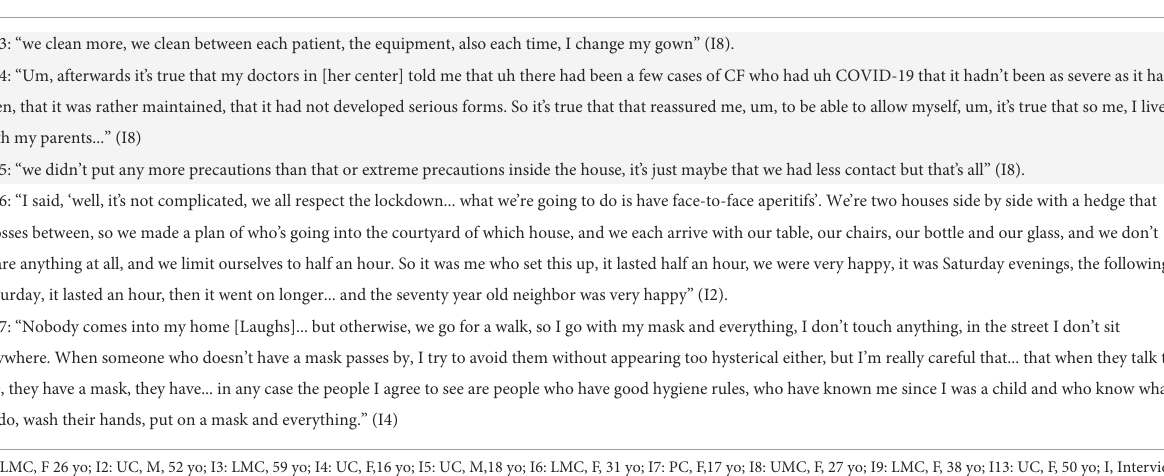
(Supplementary Table 2). Analysis of the 725